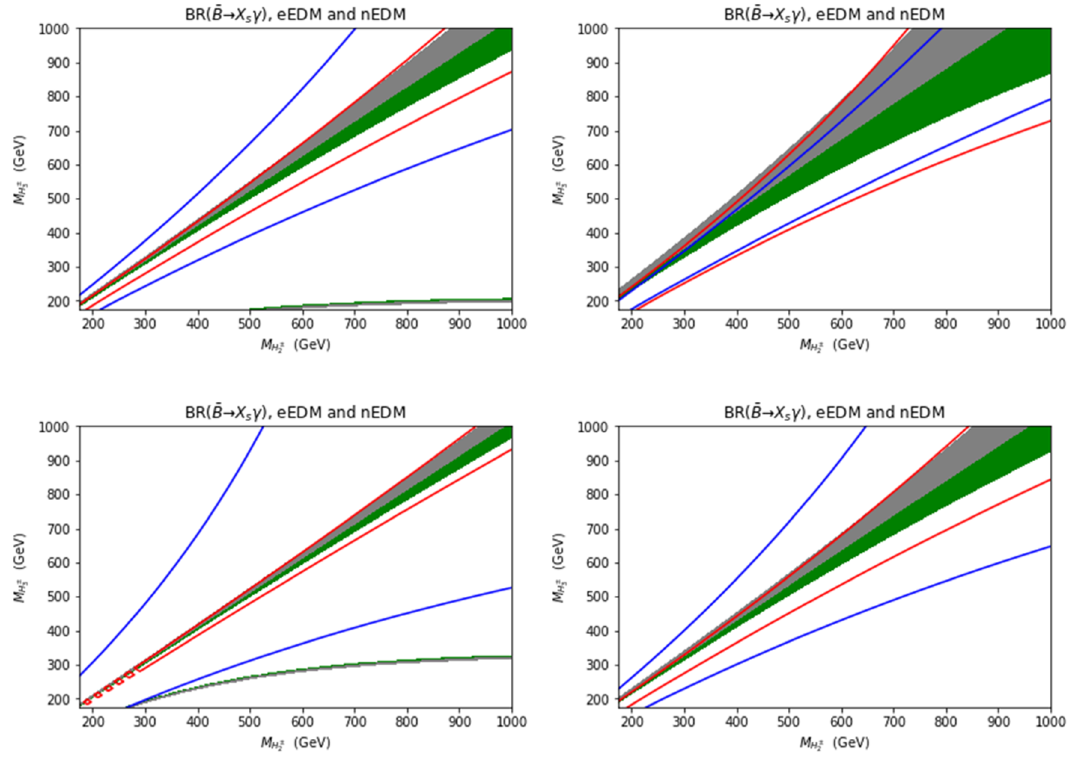
Figure 21 . Same as figure 18 but with θ = − π/ 4